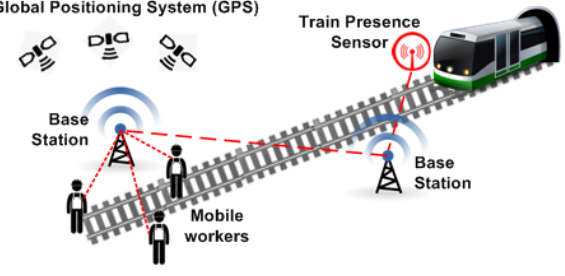
Figure 3. WBANs for Mobile Workforce Safety and Health Management Application Use-Case 1.